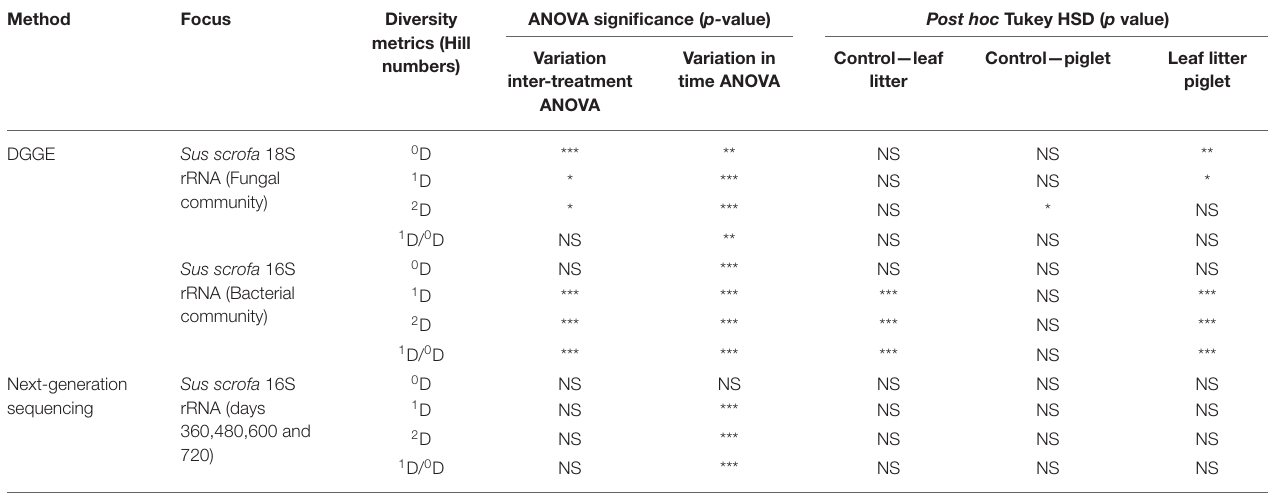
TABLE 1 | Statistical significance for richness ( 0 D), common taxa diversity ( 1 D), dominant taxa diversity ( 2 D), and evenness ( 1 D/ 0 D) during Sus scrofa domesticus and oak leaf litter decomposition.